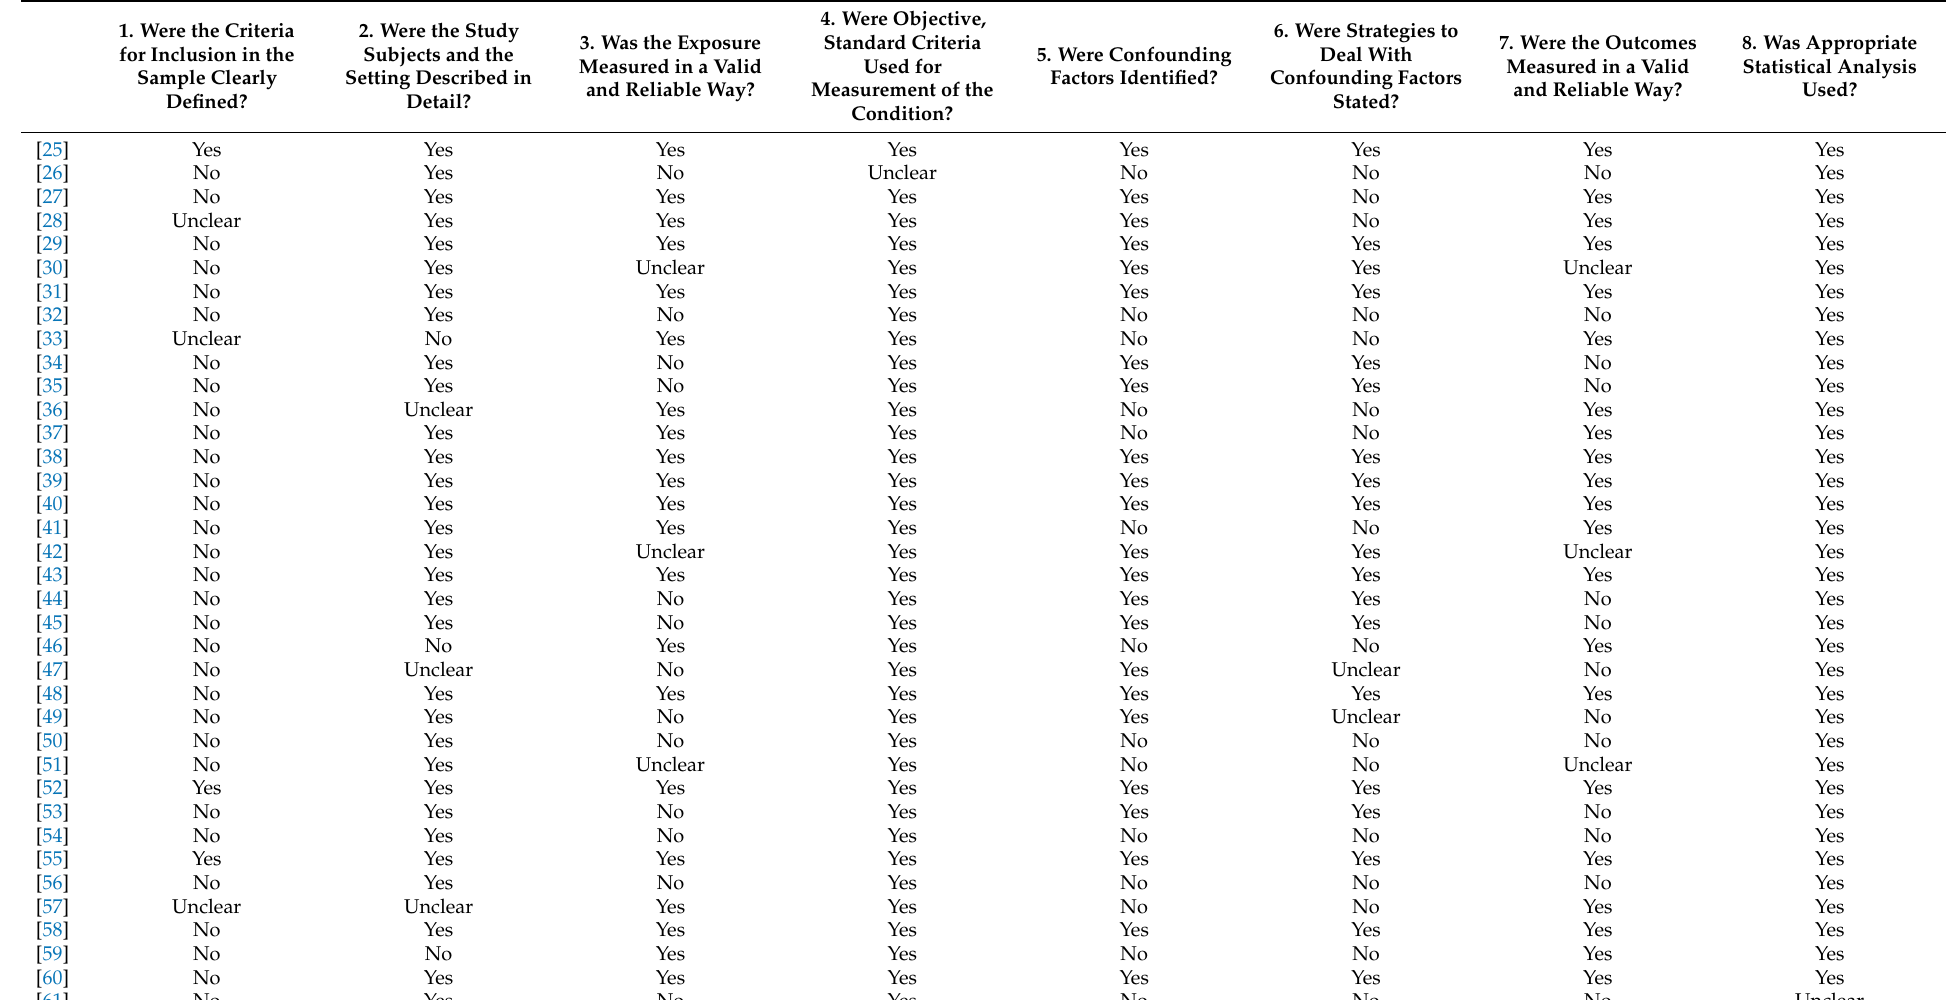
Table 1. Assessment of methodological quality of quantitative